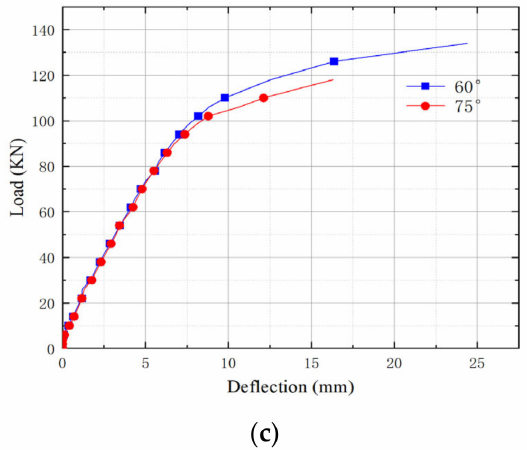
Figure 7. Composite beam load-deflection curve: ( a ) L1-60 ◦ composite beam; ( b ) L2-75 ◦ composite beam; ( c ) Mid-span comparsion of composite